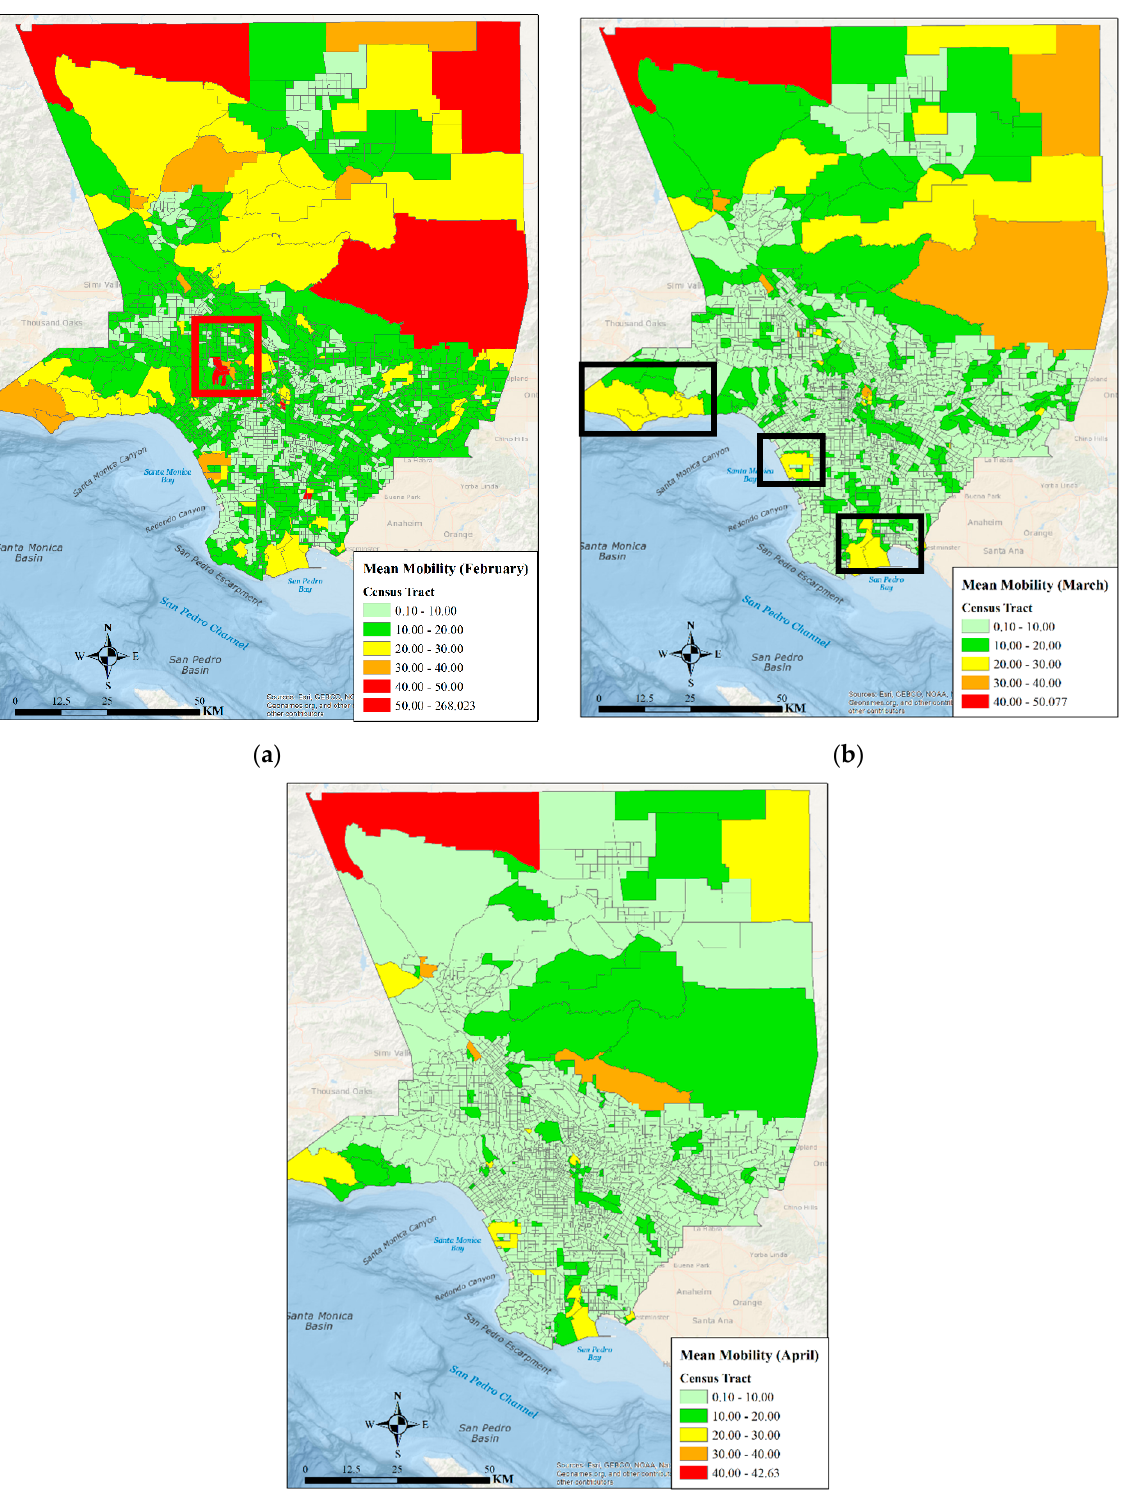
Figure 5. Mean mobility distribution in LA in February ( a ), March ( b ), and April ( c ).